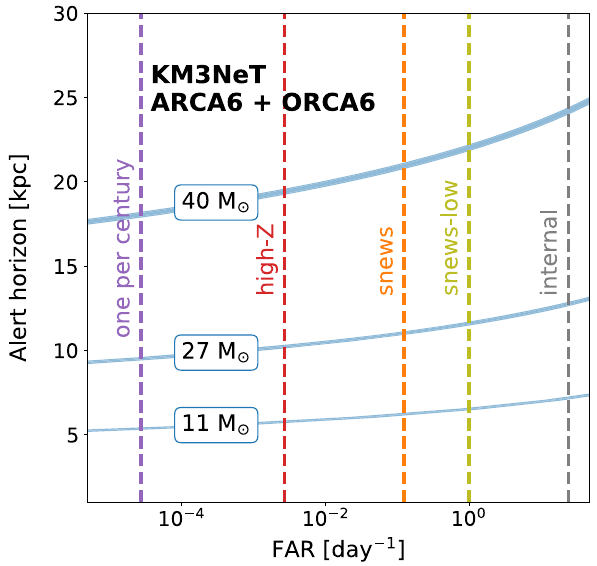
Fig. 6 Maximal source distance (blue band) for which the ARCA6 + ORCA6 detector is able to produce an alert for the FAR thresholds corresponding to the qualifiers defined in Sect. 4 plus an additional threshold corresponding to a FAR of one per century (vertical dashed lines). The band width accounts for the variability of the background and signal expectations shown in Fig.